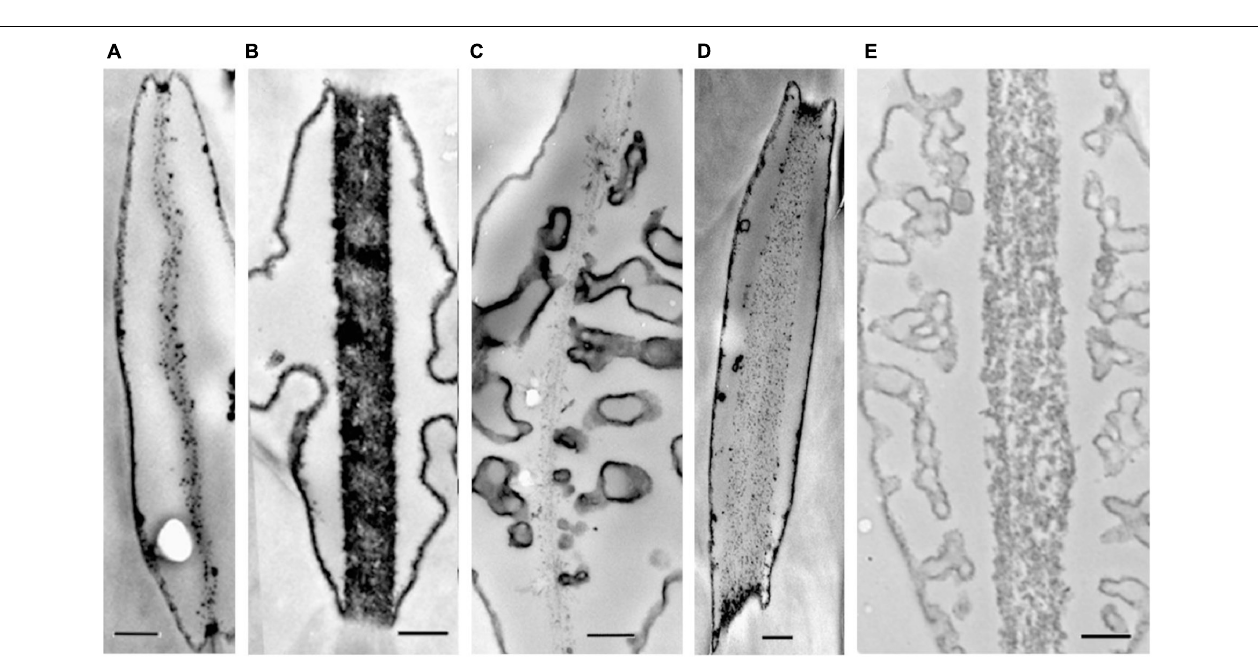
FIGURE 3 | Maximum xylem vessel diameter (A) , range in vessel diameter (B) , and vessel density (C) by growth form and forest type. Letters indicate significant ( P < 0.05) differences among groups based on Tukey’s HSD tests. Box plot midlines show medians, box edges, first and third quartiles, whiskers, minima and maxima, and points, outliers.